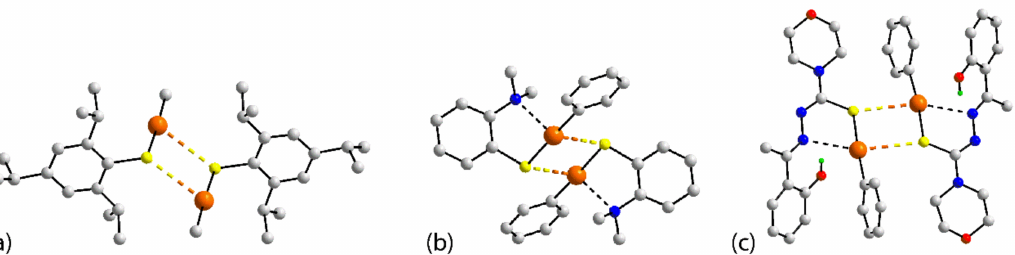
Figure 5. Supramolecular association in zero-dimensional aggregates featuring a { ··· HgS} 2 synthon: ( a ) 26 , ( b ) 21 and ( c ) 23 .